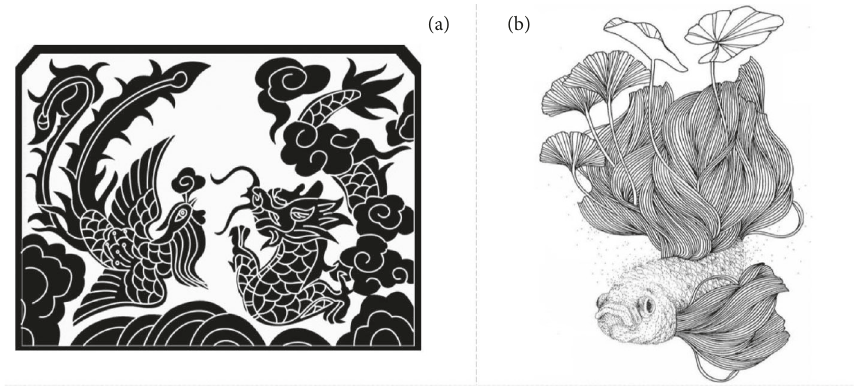
Figure 1: Learning materials of blind